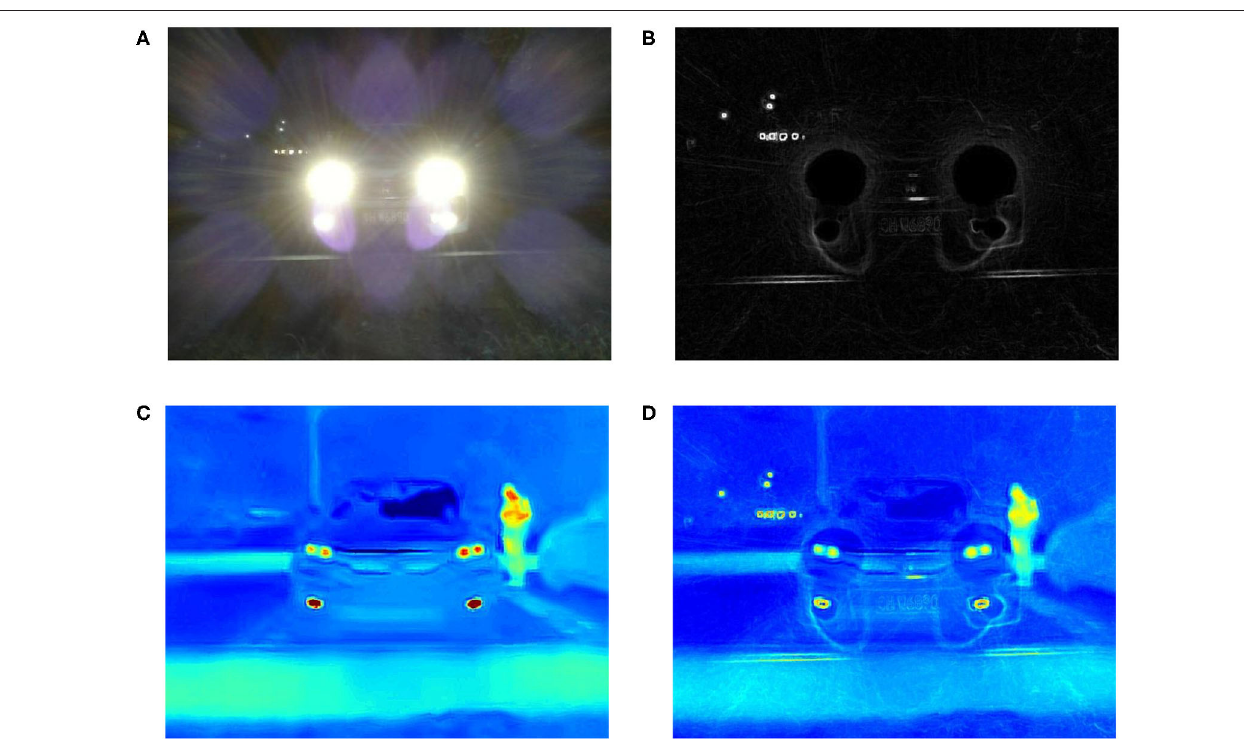
vehicle headlight were extracted by the Sobel operation, as